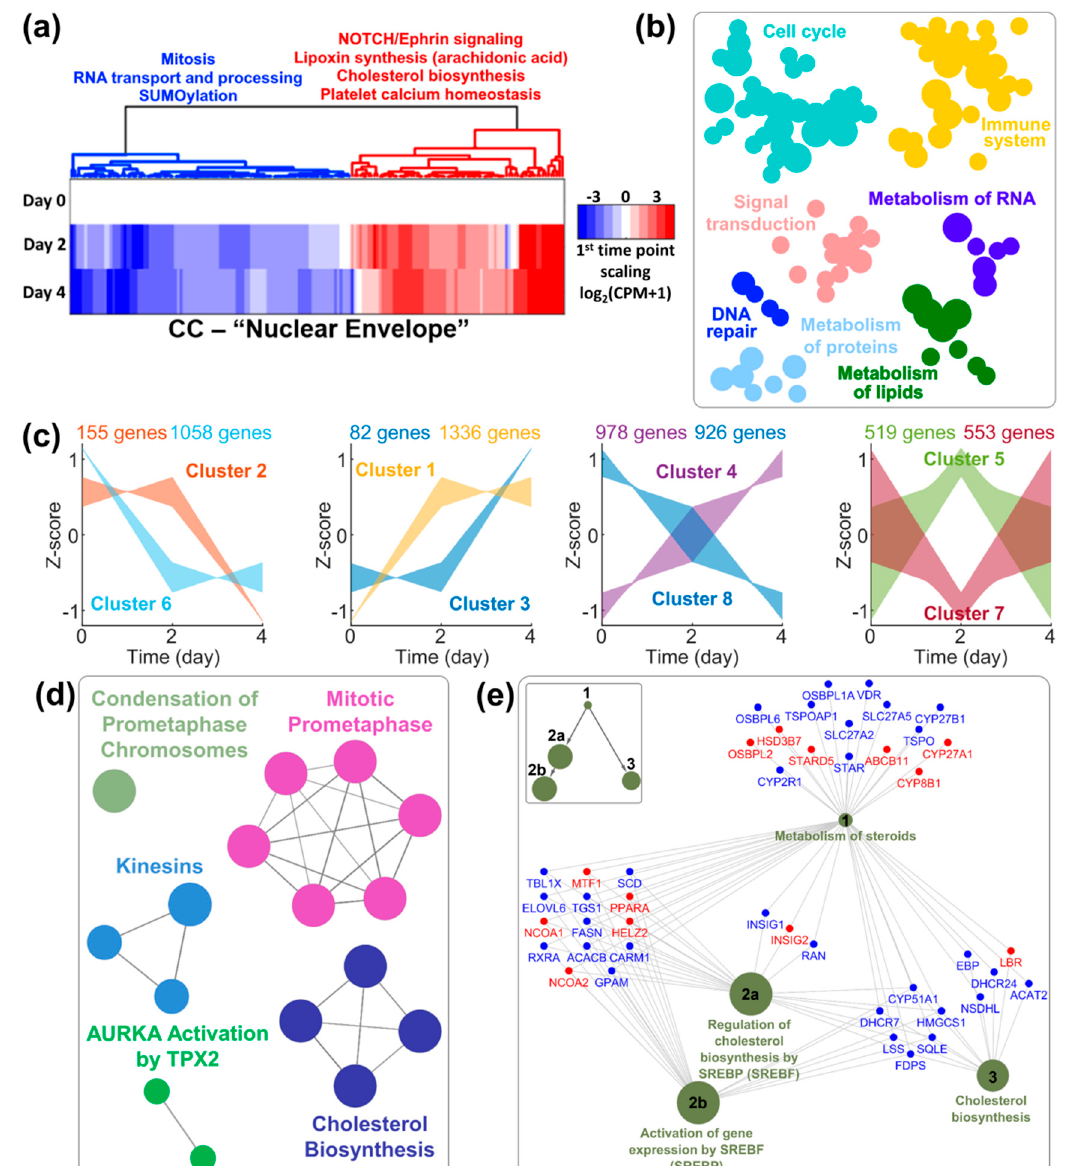
Figure 3. Transcriptomic profiling of HL60 differentiation. ( a ) Differentially expressed genes (DEGs) in the “Nuclear Envelope” Cellular Component category clustered according to expression pattern, with main Reactome terms for cluster enrichment analyses. ( b ) Reactome categories for enrichment analyses of all DEGs between Day 4 and Day 0 (enrichment analysis, B-H post-test, p < 0.05). ( c ) DEG clustering according to temporal expression profile at the three considered time-points. ( d ) Reactome terms (clustered according to k-score) for late downregulated DEGs (cluster 2 in ( c )) (enrichment analysis, B-H post-test, p < 0.01). ( e ) Gene network of dark-blue cluster shown in ( d ) showing downregulation (blue) of the majority of DEGs in the “Cholesterol biosynthesis” node between Day 0 and Day 4, with only laminB-receptor (LBR) upregulated (red). Inset: Hierarchical Reactome structure.